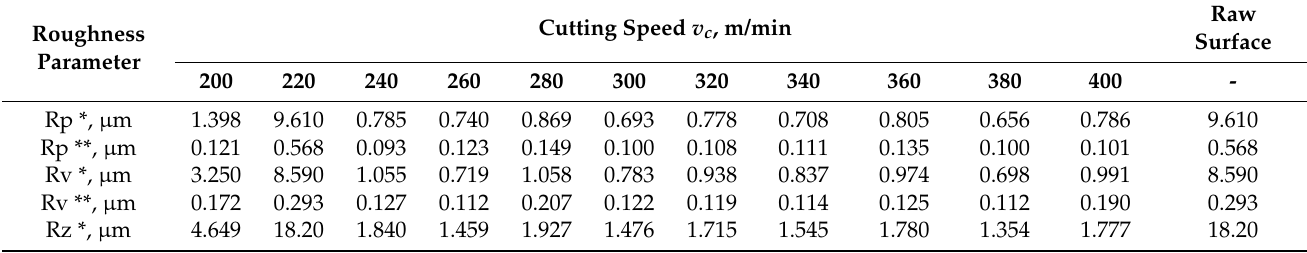
Table 5. Summary of surface roughness parameters of samples machined with a variable cutting speed.